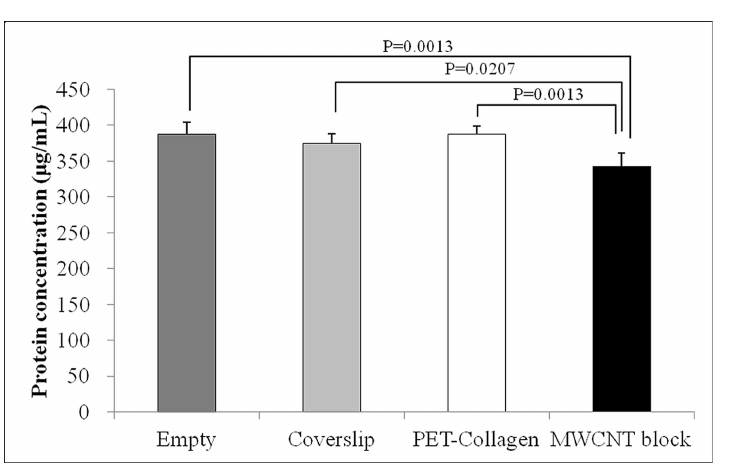
Fig 3. Protein adsorption. QualitativeProtein Adsorption Profiles of MWCNT blocks and PET-reinforced collagensheets. Values are mean ± S.D.; n =